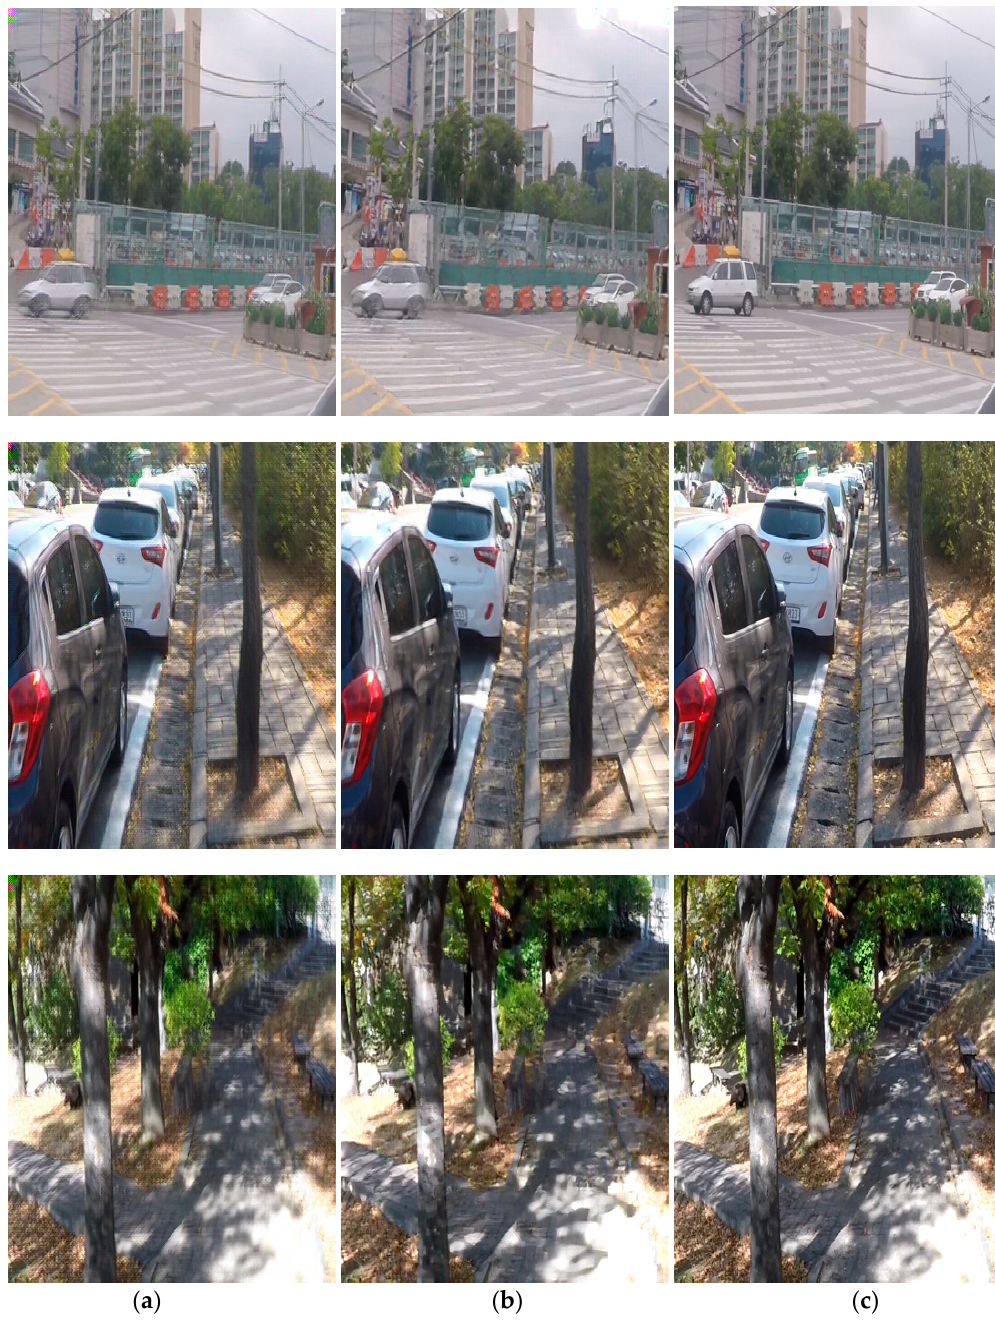
Figure 20. Background images from comparing proposed method with WGAN-GP using content -based methods: ( a ) WGAN with content loss ( b ) Proposed method ( c ) Original sharp image.